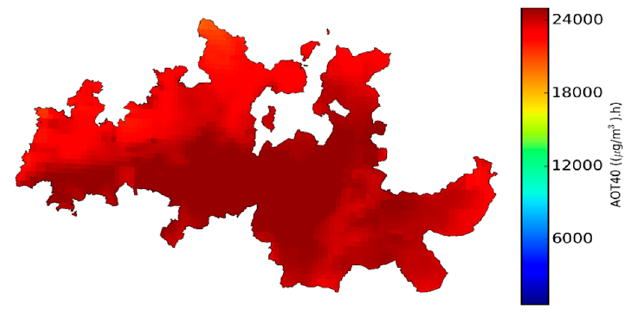
Figure 10. Sugar content loss (%) in DDR (D04, 1 × 1 km 2 horizontal resolution), averaged for the Figure 8. AOT40 levels ( μ g·m − 3 ·h) averaged for the 3 simulation years in the DDR (D04, 1 × 1 km 2 3 simulation years and based on Soja et al. (2004) exposure–response functions. horizontal resolution).